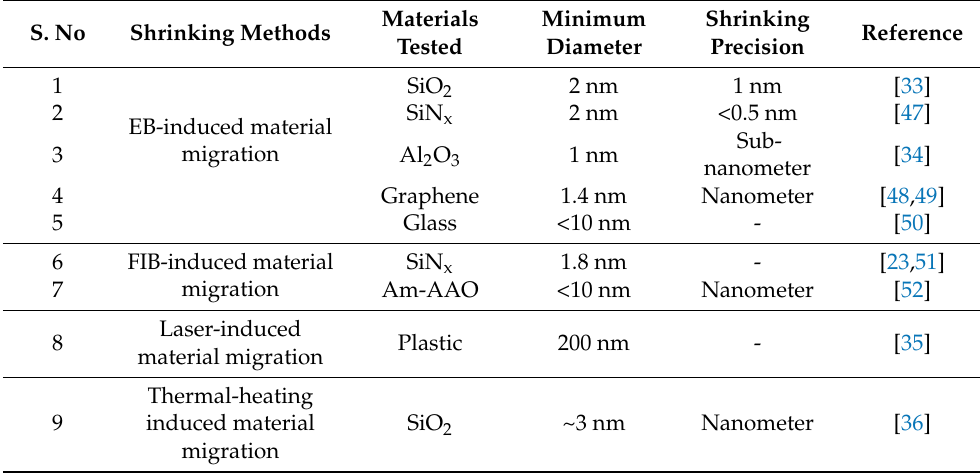
Table 1. Comparison of material migration